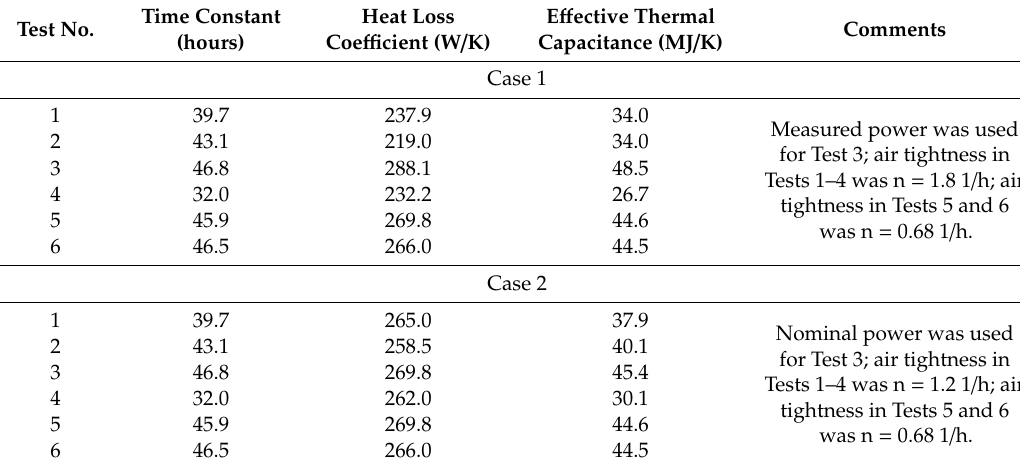
Table 3. Dynamic heating test